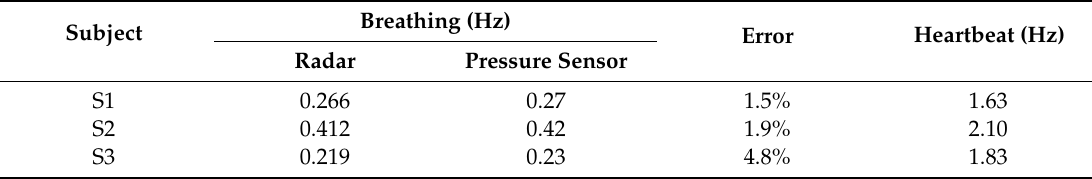
Table 1. Vital sign measurement results of three beagle dogs.